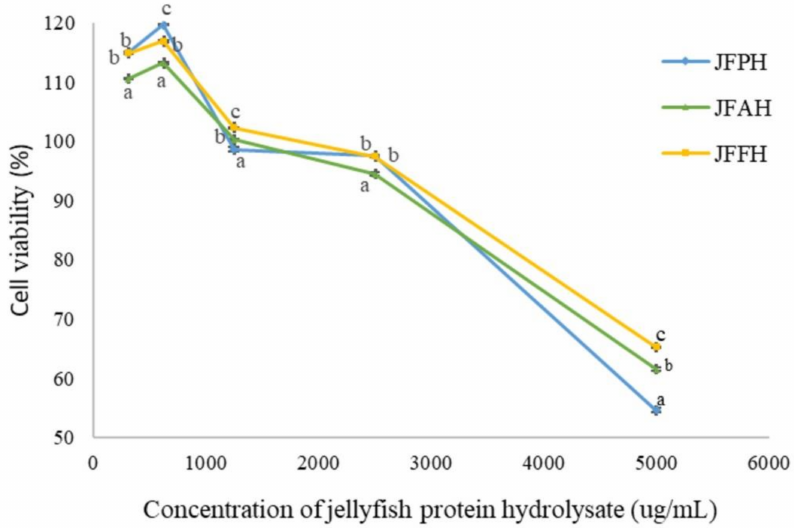
Figure 4. Cytotoxic effect of jellyfish hydrolysate prepared with alcalase (JFAH), flavourzyme (JFFH), and papain (JFPH) on human keratinocytes cells (HaCaT) at 24 h incubation.